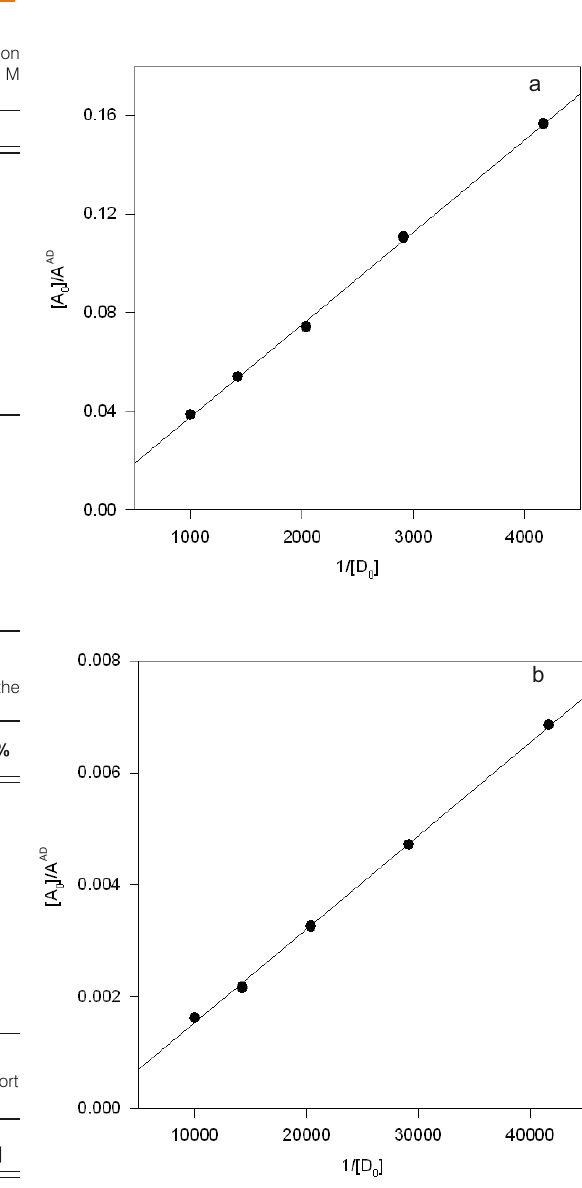
Figure 4. Benesi-Hildebrand plot for a) SU-chloranilic acid complex, λ = 518 nm and b) SU–iodine complex, λ = 363 Statistical comparison of the accuracy and precision